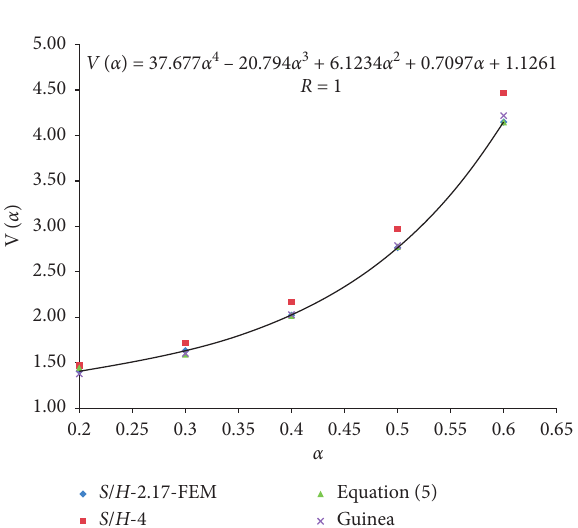
Figure 2: Y ( α ) versus relative crack length α (square red points indicate values obtained from formulas of Tada et al. for S / H � 4).